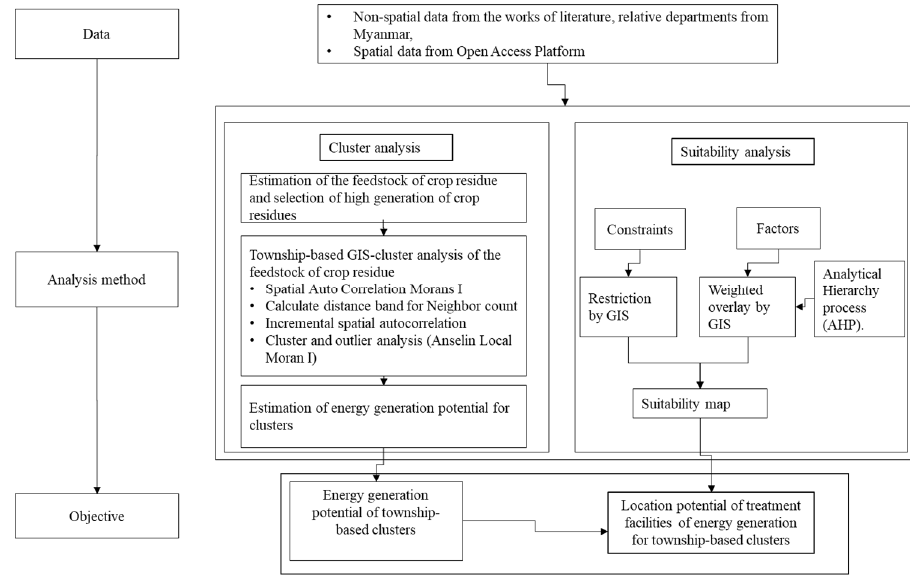
Figure 2. Research Framework